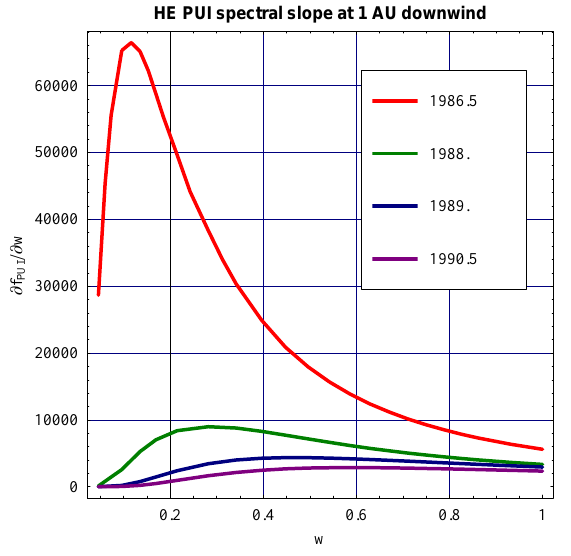
Fig. 21. Slopes of f PUI at four different phases of the solar cycle at 1 AU, downwind position; w = v/V is speed normalized to solar wind